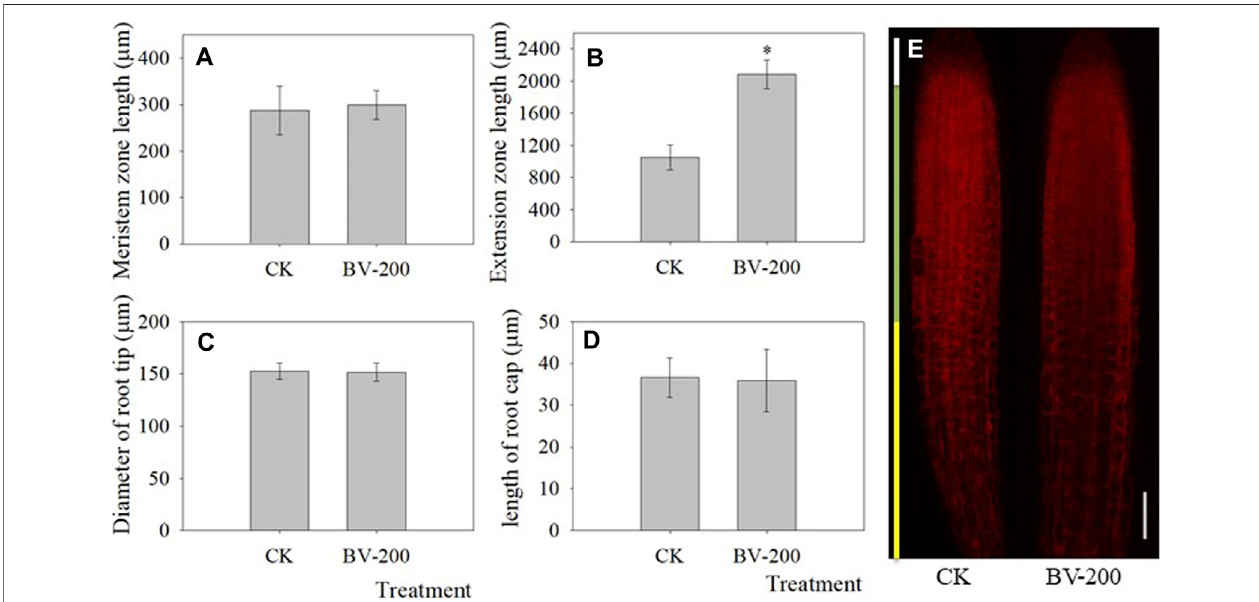
FIGURE 4 | Effect of BV nanomaterials on primary root length in Arabidopsis . (A) Meristem zone length of primary root. (B) Extension zone length of primary root. (C) Diameter of root tip. (D) Length of the taproot cap. (E) Representative images of roots stained with PI to outline the living cells, showing the root cap, meristem domain, and extension zone after 4 days of incubation. Scale bar (cid:2) 50 μ m. CK: the control without adding BV. BV-200: 200 μ g ml − 1 BV treatment. N (cid:2) 30. Asterisks above the bar indicate that there were signi fi cant differences between the two treatments at p < 0.05.